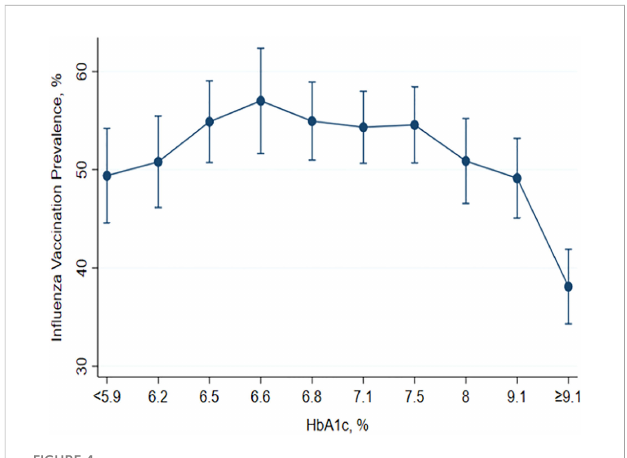
FIGURE 4 Prevalence of in fl uenza vaccination according to glycemic control in participants with diabetes